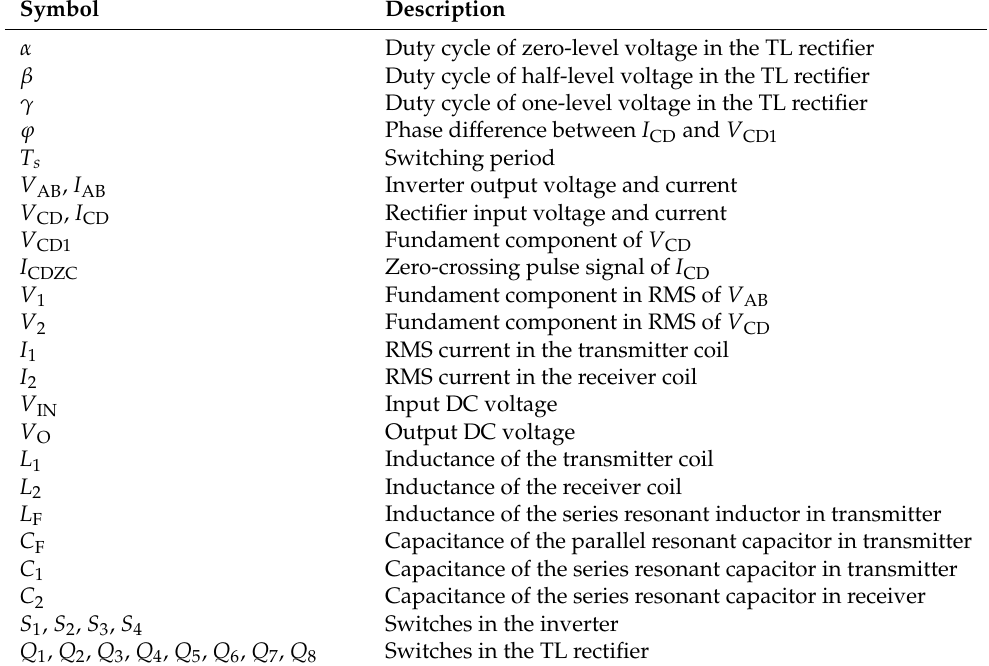
Table 1. Definition of the key